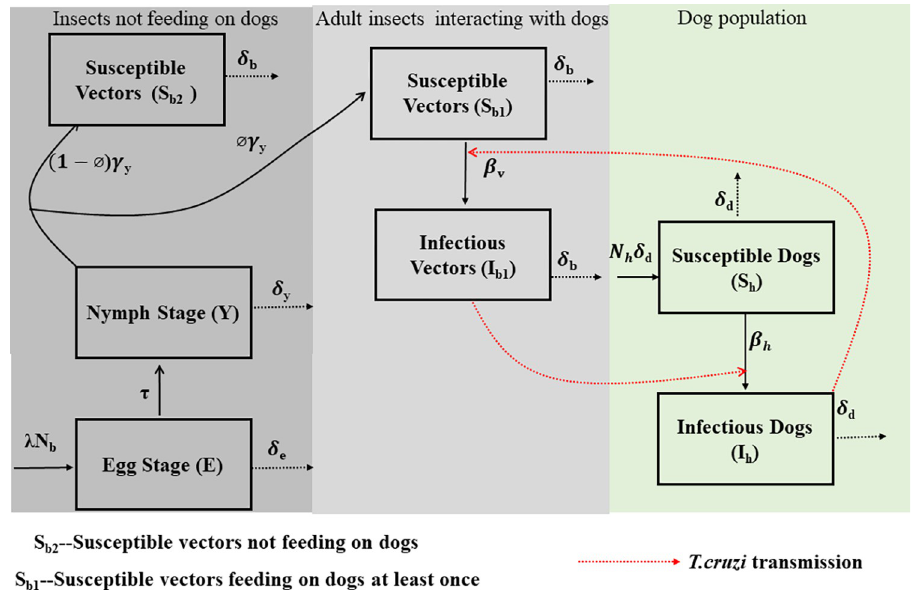
Fig 1. Single vector-host population model